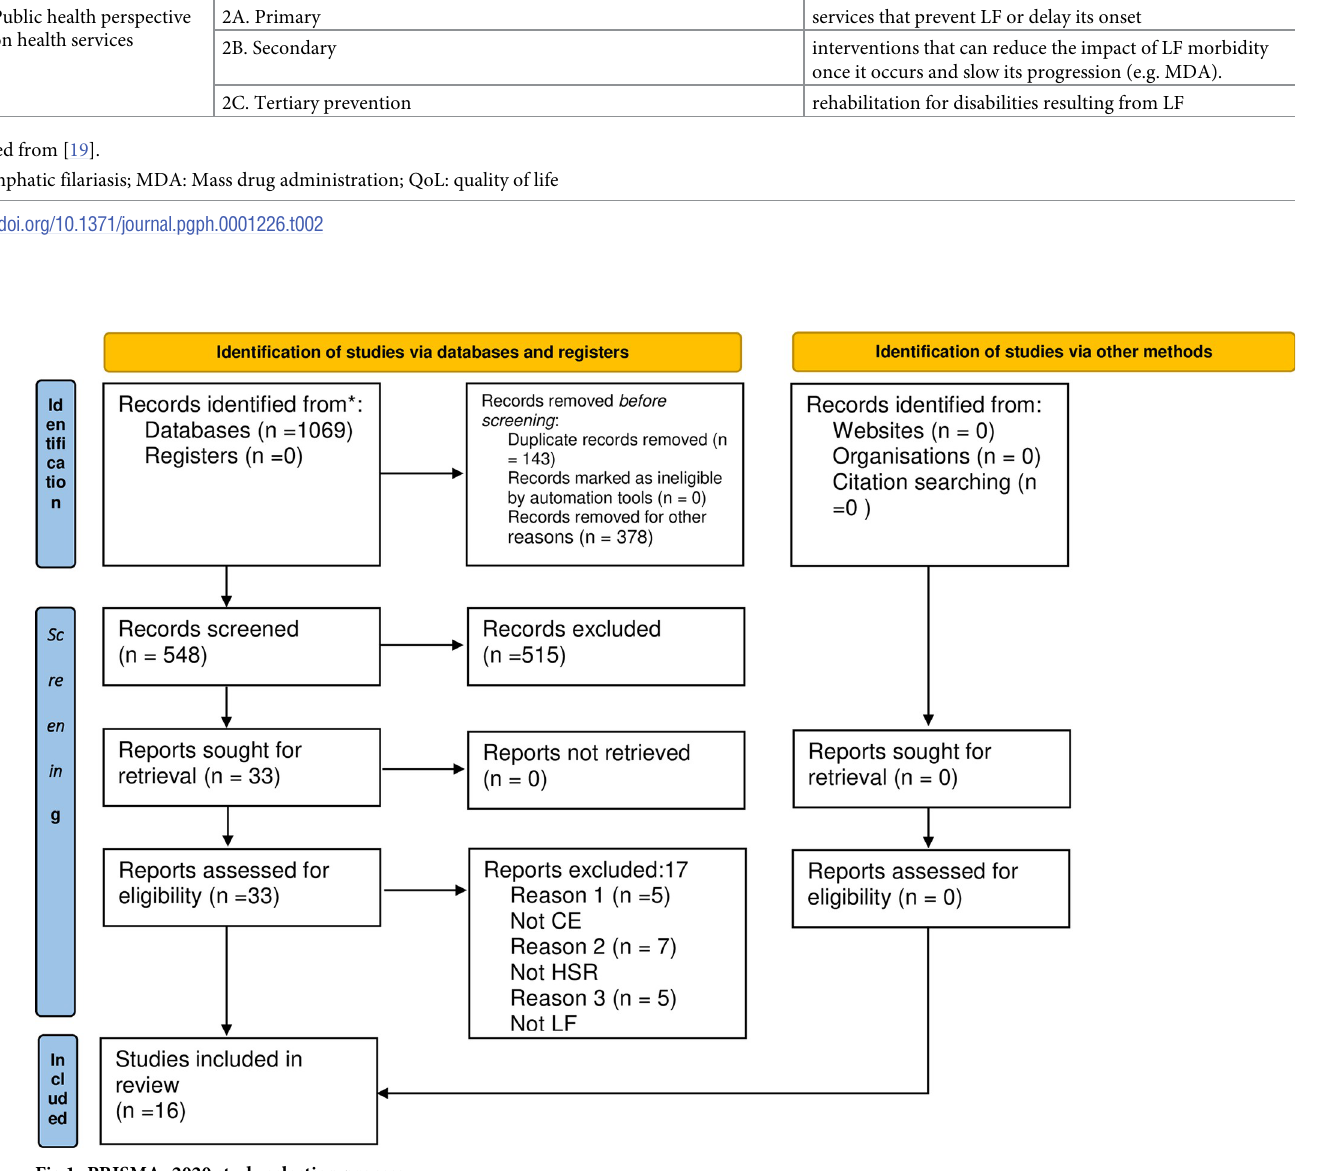
Fig 1. PRISMA- 2020 study selection